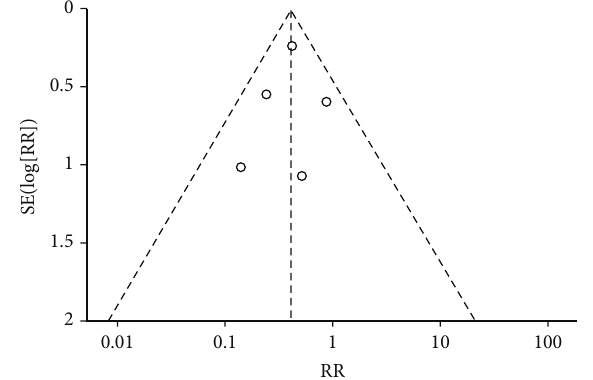
Figure 5: Funnel plot analysis of publication bias. The outcome impact of NAs on the 1-year HCC recurrence